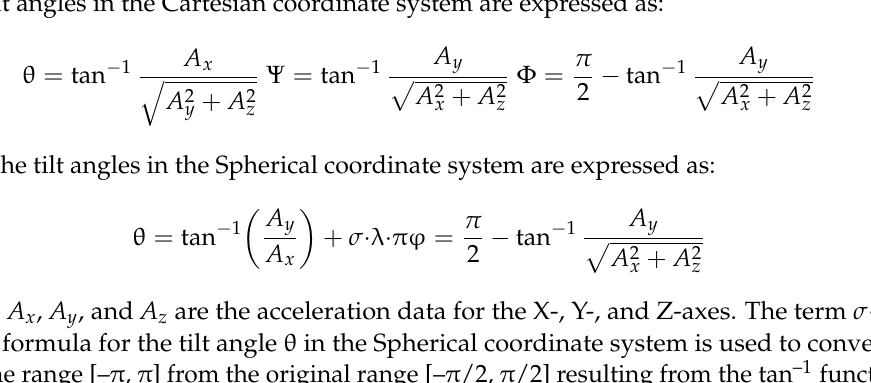
Figure 4. Coordinate systems with their defined tilt angles. ( a ) Spherical Coordinates, ( b ) Cartesian Coordinates. The tilt angles θ , Ψ , and Φ in the Cartesian coordinate system and θ and ϕ in the Spherical coordinate system can be calculated using Equations (1) and (2),